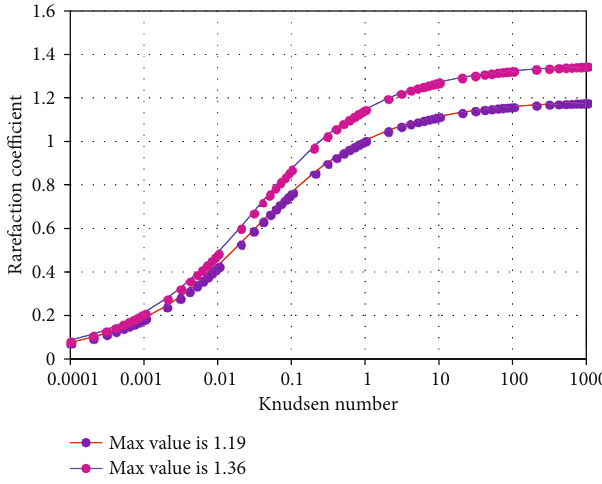
Figure 1: Gas rarefaction coe ffi cient with di ff erent empirical